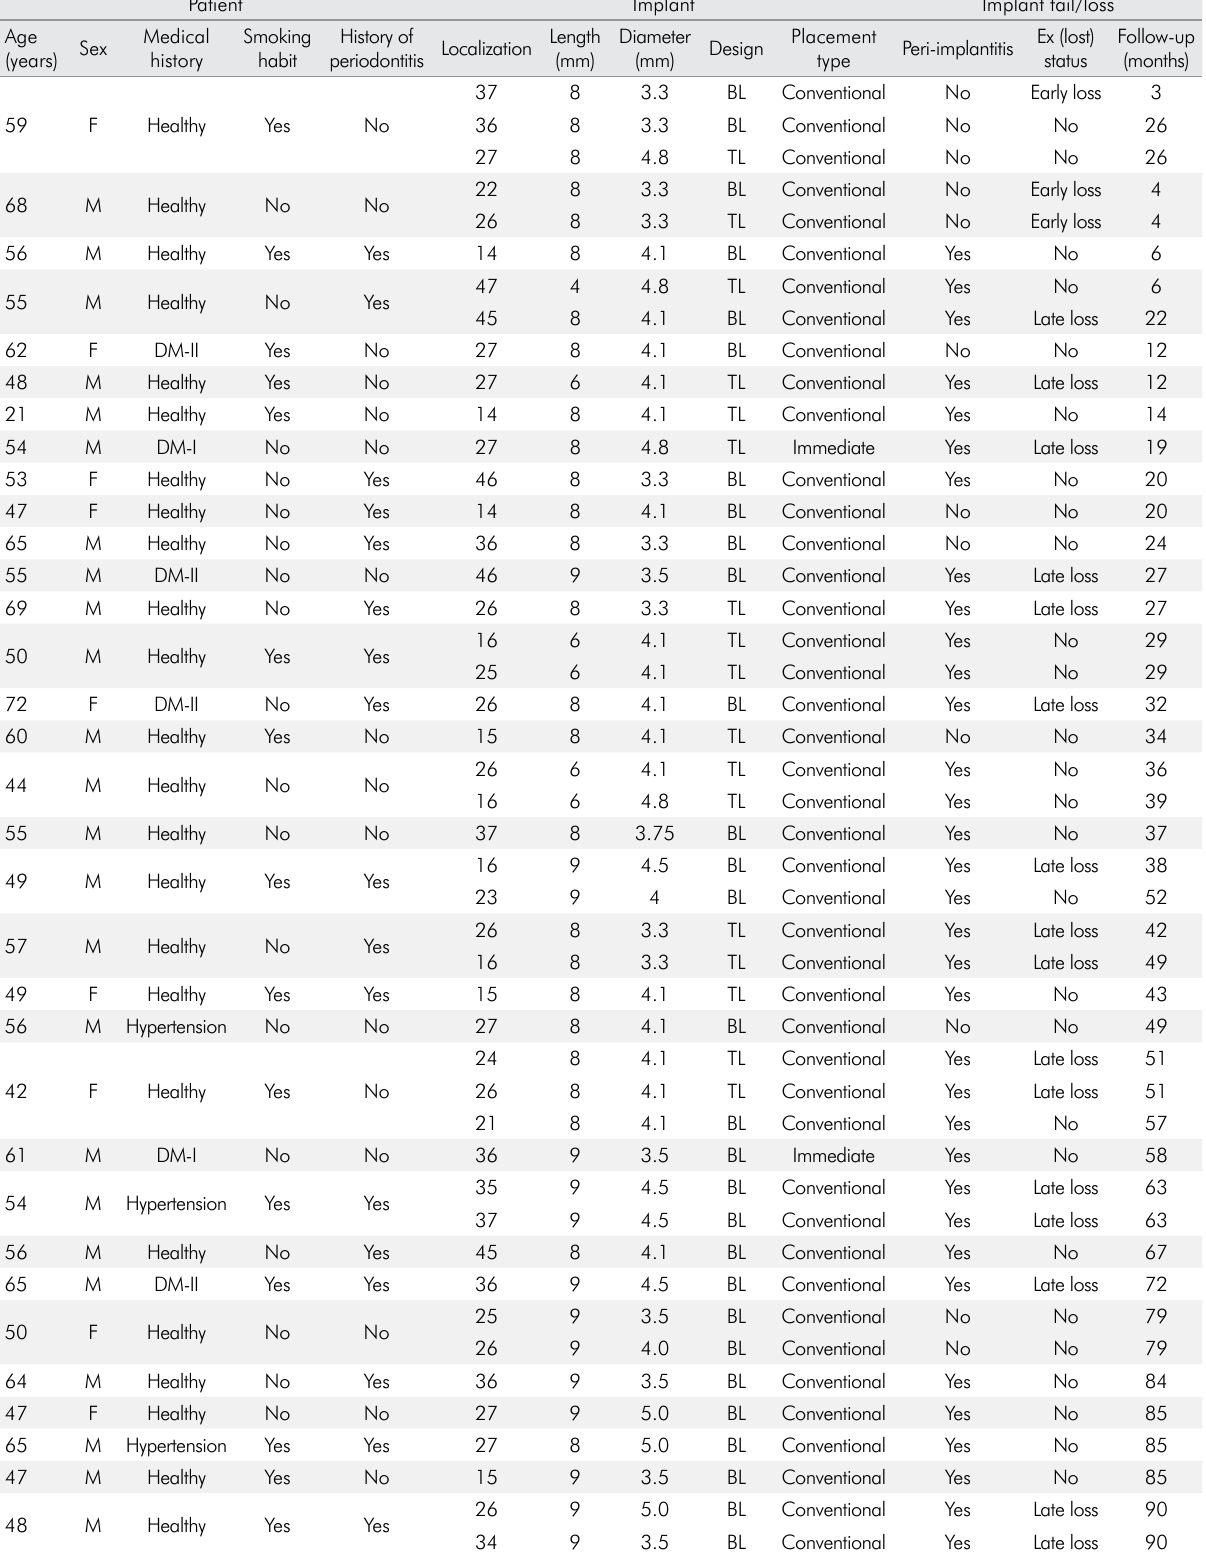
Table 4. Distribution of the different variables in relation to failed (unsuccessful) short